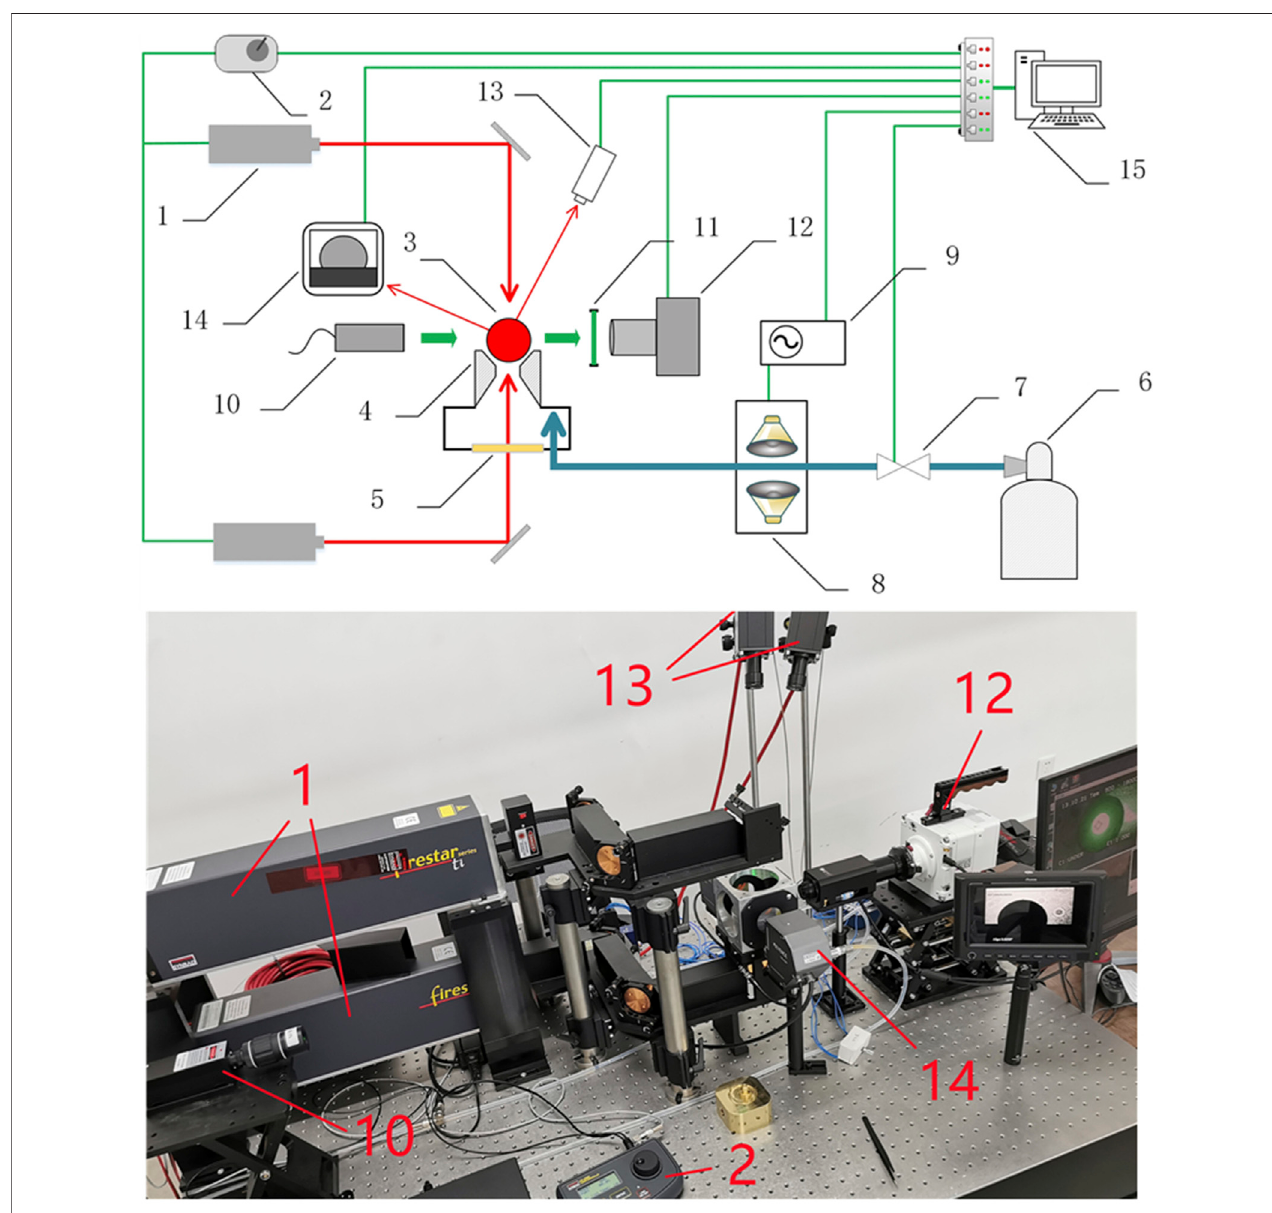
FIGURE 1 | Schematic view and picture of the ALSEE experimental setup: 1- CO 2 laser, 2- laser controller, 3- levitated sample, 4- conical converging-diverging nozzle, 5- ZnSe window, 6- argon gas tank, 7- gas fl ow controller, 8- loudspeakers, 9- waveform generator, 10- backlighting laser, 11- narrow-band fi lter, 12- high- speed camera, 13- bichromatic pyrometers, 14- 2D optical micrometer, 15- data acquisition